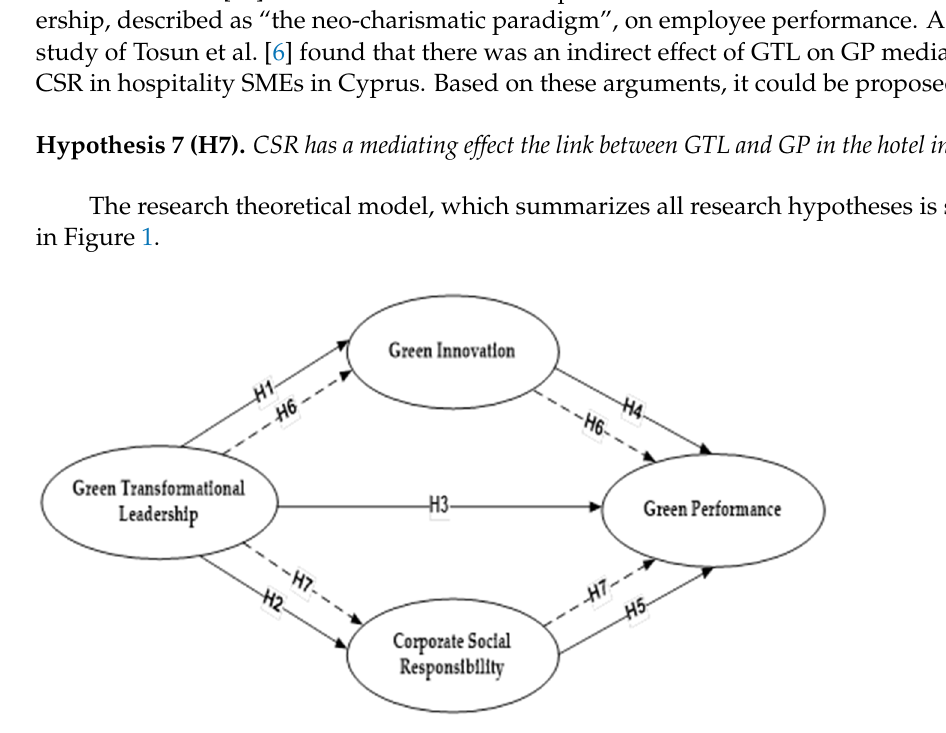
Figure 1. The theoretical model ( refers to direct effect; refers to indirect effect). (Devel- oped by the authors based upon the above literature review).